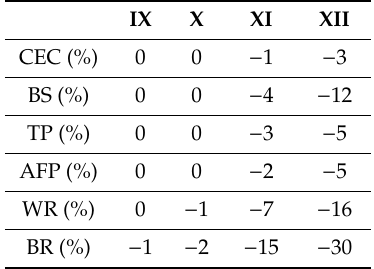
Table 6. Changes in composts characteristics following treatment with emulsion B, where: IX = 1 Lt − 1 , X = 5 Lt − 1 , XI = 10 Lt − 1 and XII = 50 Lt − 1 spraying intensity. Results are expressed as % change in comparison to blank sample (no emulsion treatment = 100%).